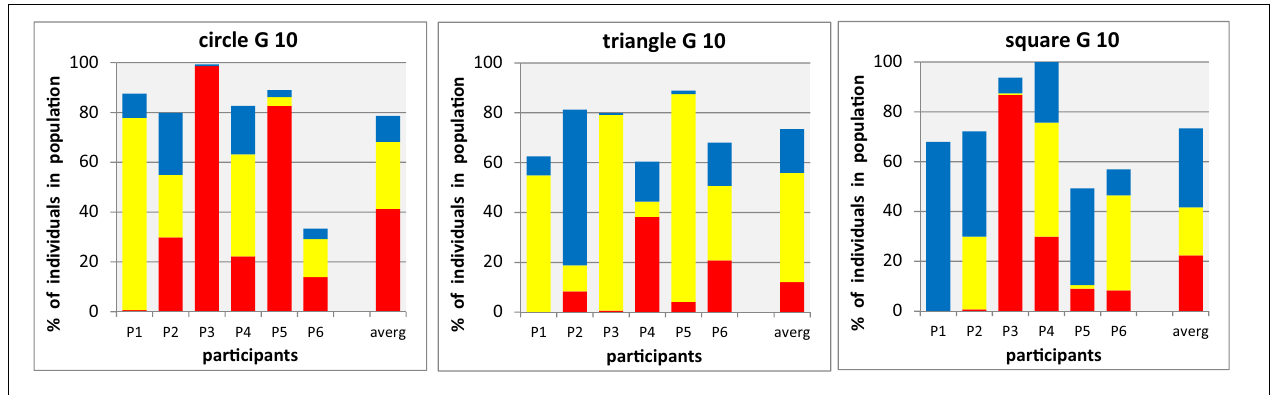
FIGURE 6 | Final stage of mixed shape populations with three shapes × threecolors (individual data from A2 for n = 6 participants, P1–P6, for details see Figure 3). Each panel shows for one particular shape (circle, triangle, square) the proportions of